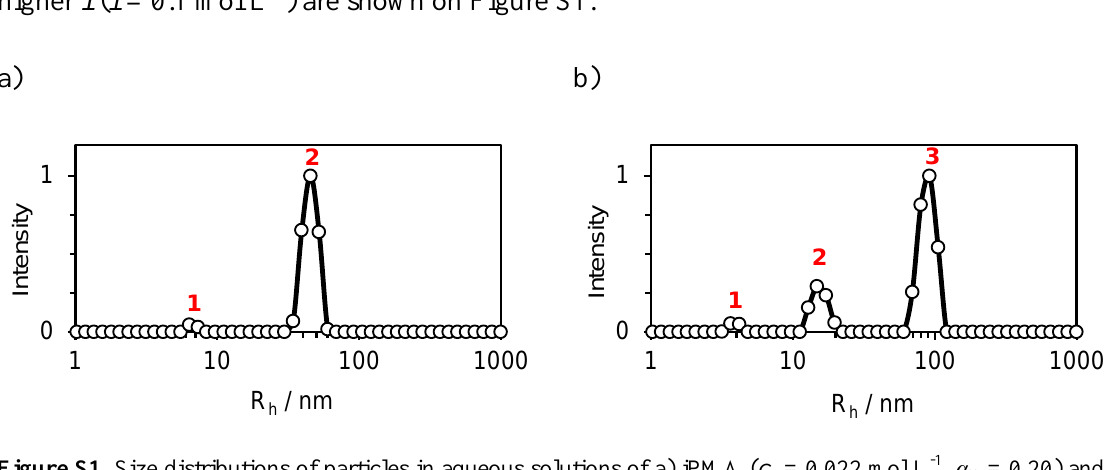
Figure S1. Size distributions of particles in aqueous solutions of a) iPMA ( c = 0.022 mol L -1 , α = 0.20) and b) p N aPMA ( c = 0.023 mol L -1 , α = 0) in CaCl with I = 0.1 mol L -1 at θ = 120°. In the iPMA case, peak 1 p N 2 corresponds to small particles and peak 2 to associates (with R ). In the aPMA case, peaks 1 and 2 correspond h,ass to individual chains and smaller associates, while peak 3 applies to larger aggregates with R h,ass